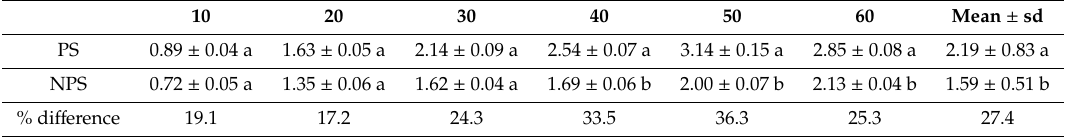
Table 1. Dynamics of cocoon production by E. fetida (cocoons worm − 1 ) over time (days in bold) depending on the technology (PS or NPS) used in the construction of